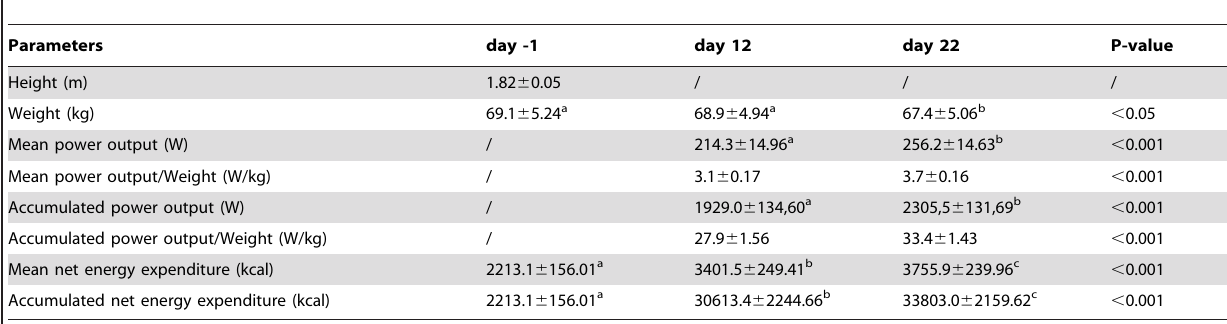
Table 2. Anthropometric and power-related measurements across the stage race.